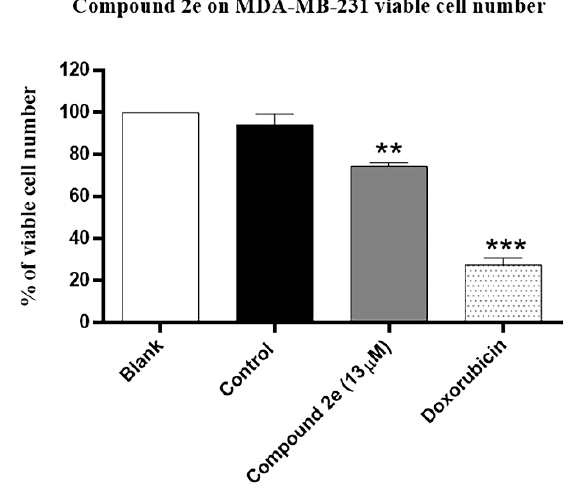
Figure 1. Effect of compound 2e on MDA-MB-231 viable cell number, determined by trypan blue exclusion assay. Cells were treated for 48 h with medium (Blank), control (DMSO; vehicle),